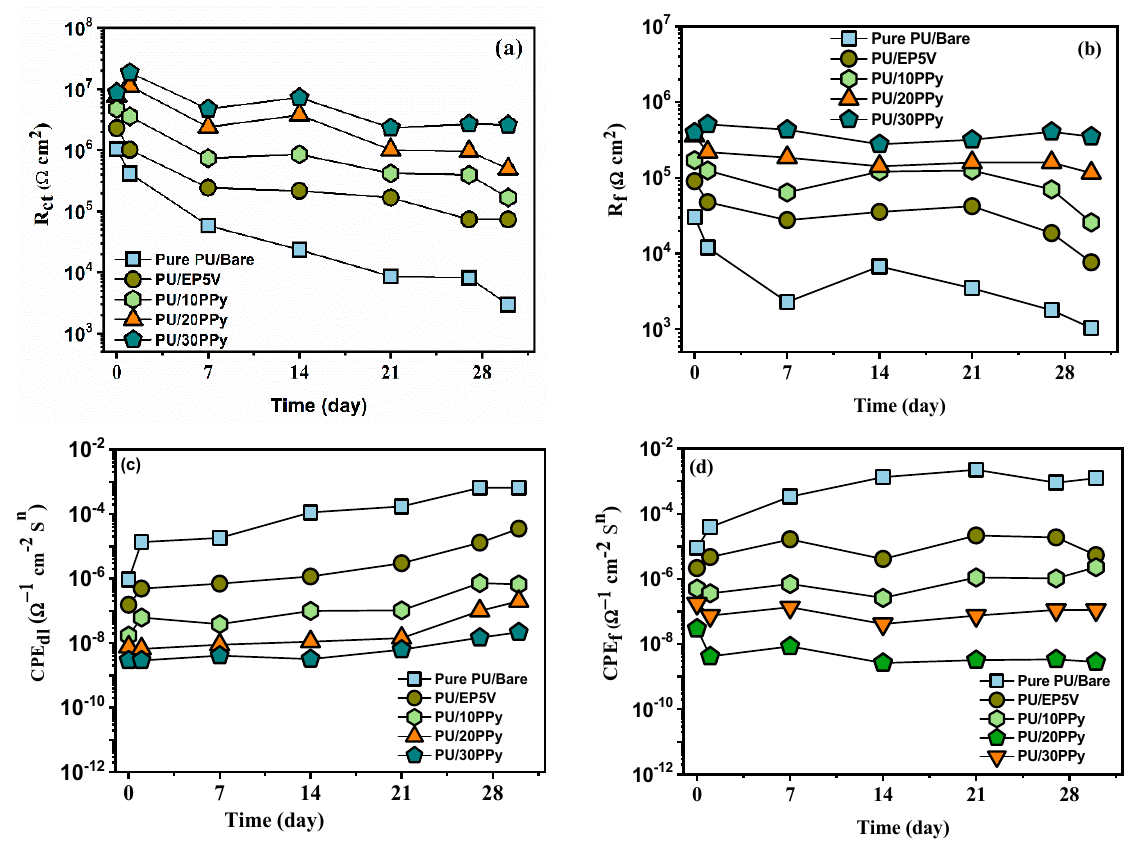
Figure 11. EIS circuit parameters for the prepared coatings on passivated and bare specimens in a 3.5% NaCl solution in different immersion periods ( a ) R ct , ( b ) R f , ( c ) CPE dl, and ( d ) CPE f . The surface morphologies of PU/PPy composite coatings on passivated specimens before and after 30 days in a NaCl solution were examined using SEM analysis to attain pictorial evidence of the corrosion reactions occurring at the SS/PU interface. Figure 12a–d presents the PU/PPy composite coating surface on the bare and passivated specimens; the surface of the coatings is featureless and plain without any observable